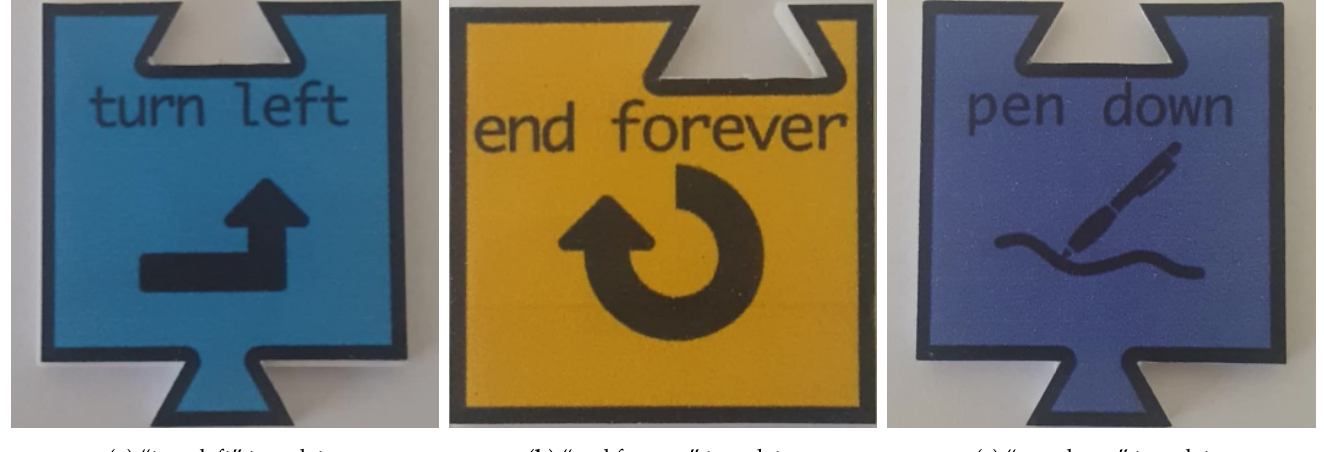
Figure 5. Three templates of the 32 template